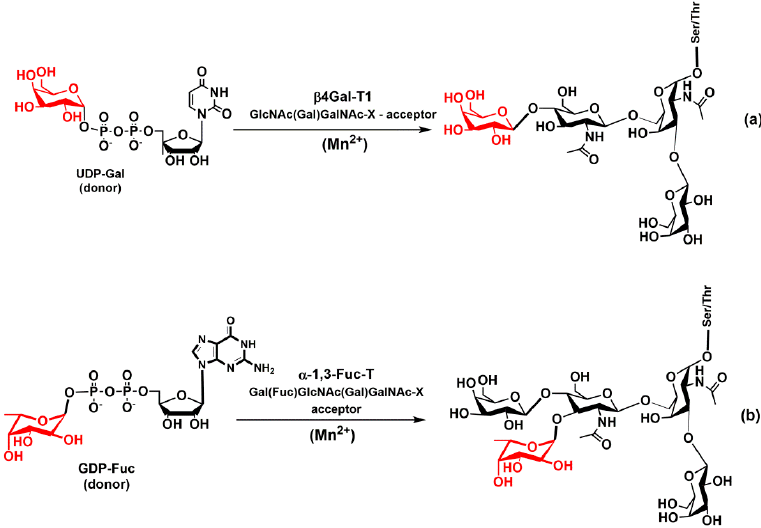
Figure 8. Schematic diagram of enzymatic reaction catalyzed by ( a ) β 4Gal-T1 and ( b ) α 1,3FucT.